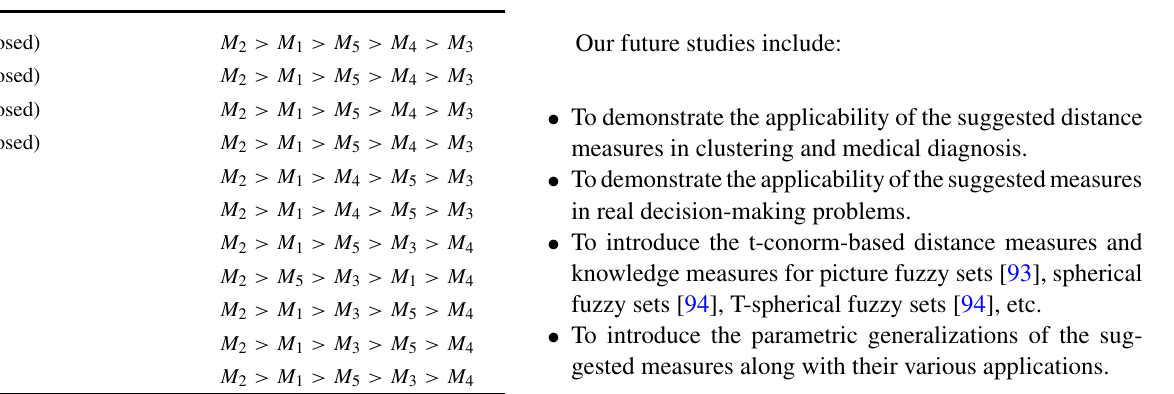
Table 11 Ranking of alternatives